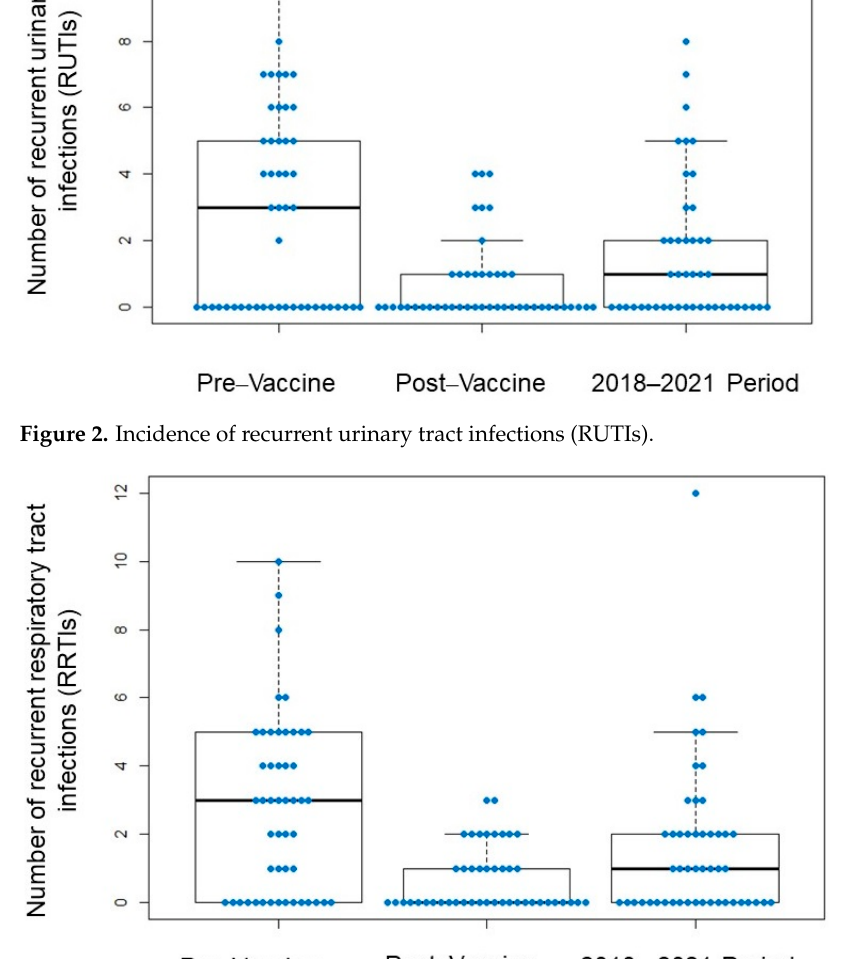
Figure 3. Incidence of recurrent respiratory tract infections (RRTIs).